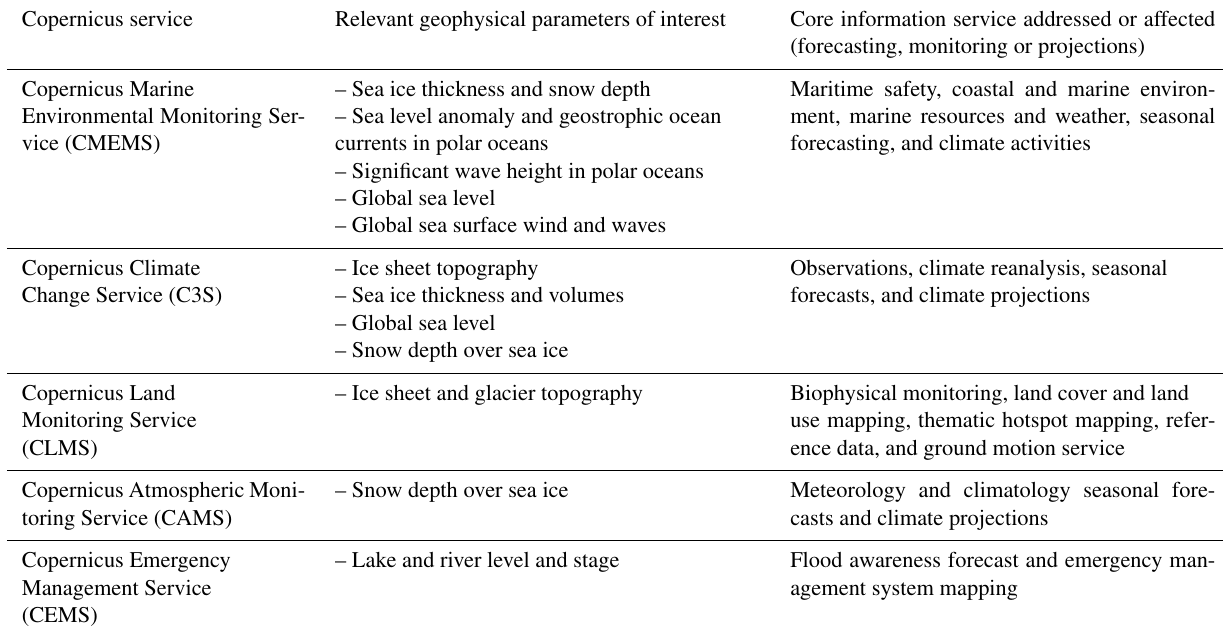
Table 2. Copernicus services addressed by